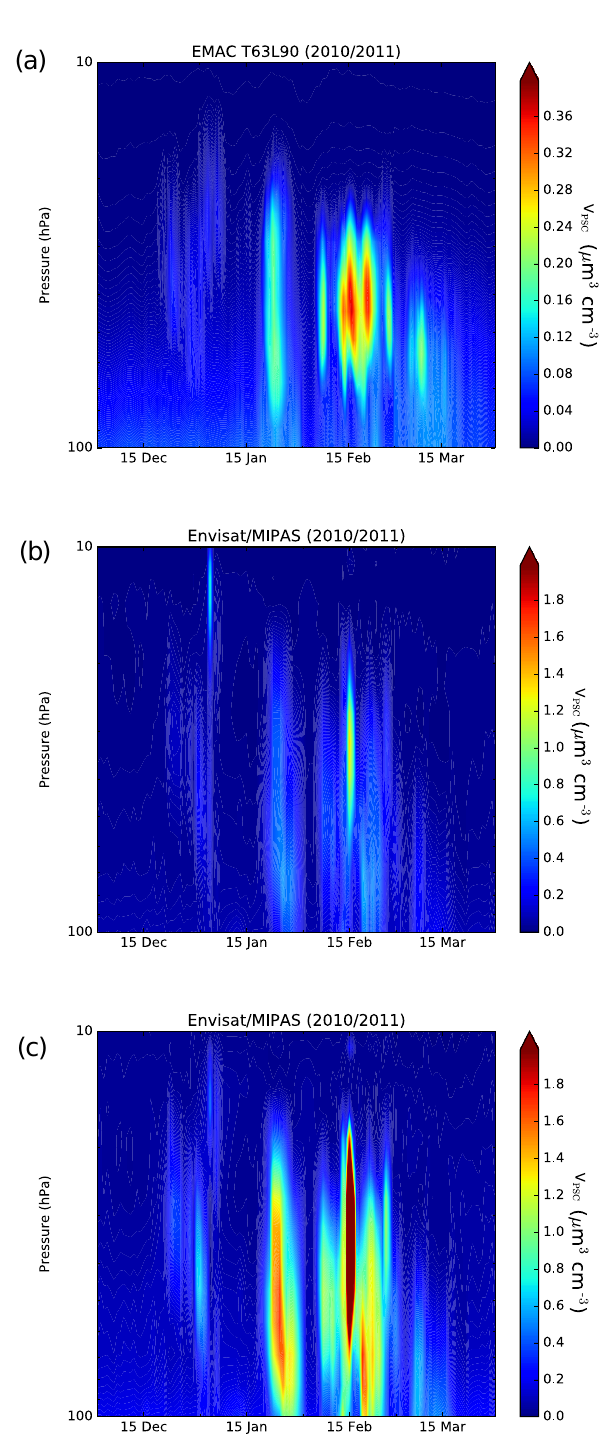
Figure 10. Volume density of all (liquid and solid) PSC parti- cles ( V PSC ) in µm 3 cm − 3 as simulated with EMAC (a) and ob- served with Envisat/MIPAS lower limit (b) and Envisat/MIPAS up- per limit (c) for the Arctic winter 2010/2011. Note the different colour bar scales between the Envisat/MIPAS and EMAC